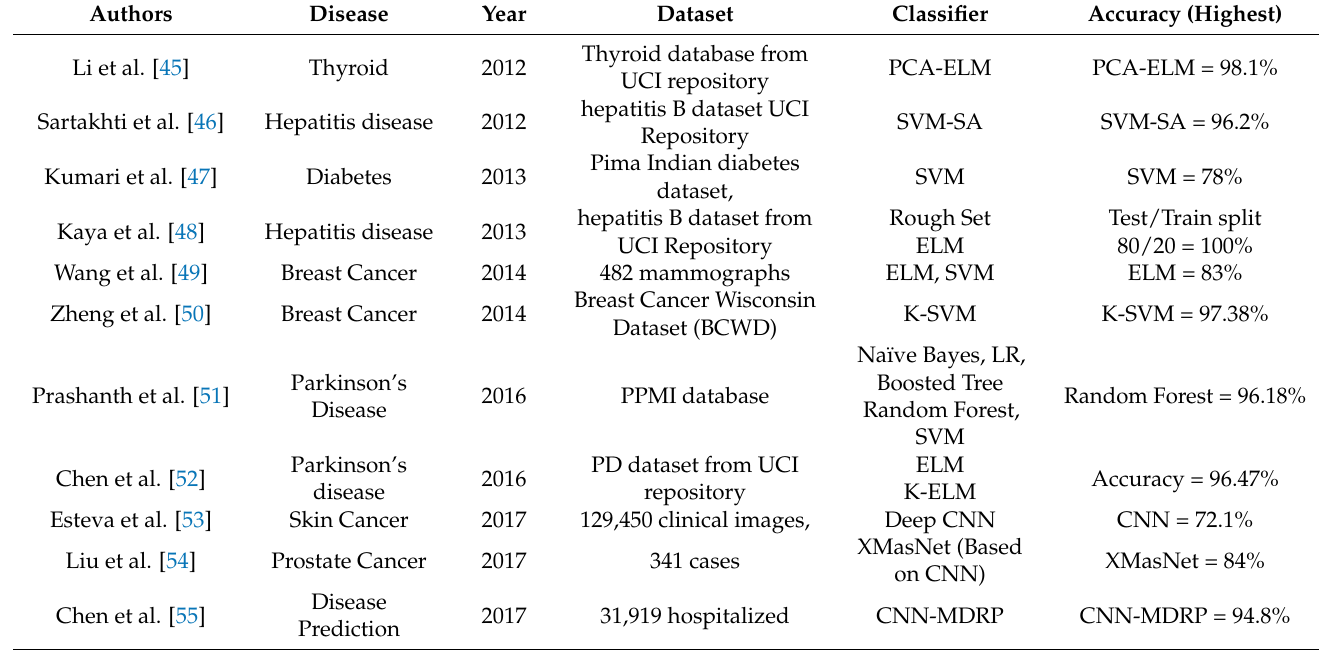
Table 1. Summary of related work on disease